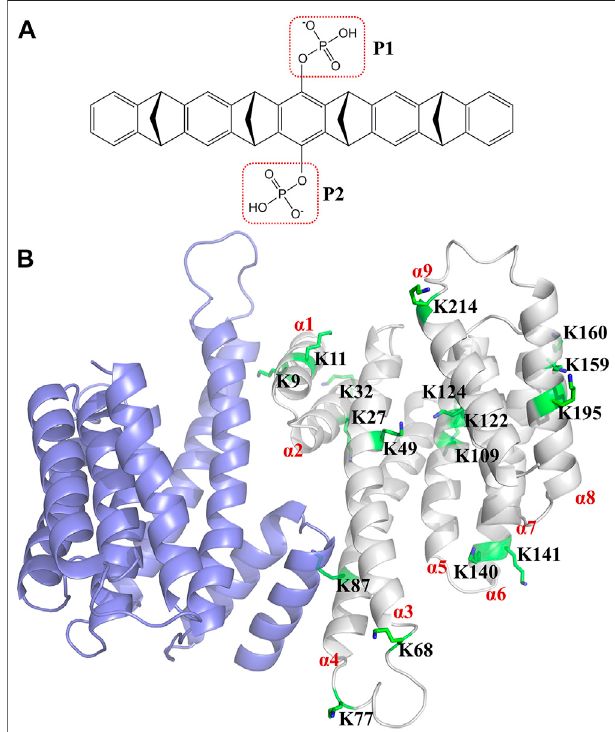
FIGURE 1 | Structure of tweezer (CLR01) and 14-3-3 σ . (A) shows the structureofthetweezer(CLR01),and (B) showsthedimericstructureof14-3- 3 σ (Protein Database Bank (PDB) ID: 1YZ5). The α -helix of the 14-3-3 σ monomer is labeled in red. The 17 lysine residues on the 14-3-3 σ monomer are represented by green sticks, and the detailed location of each lysine residue is depicted in Supplementary Figure S2